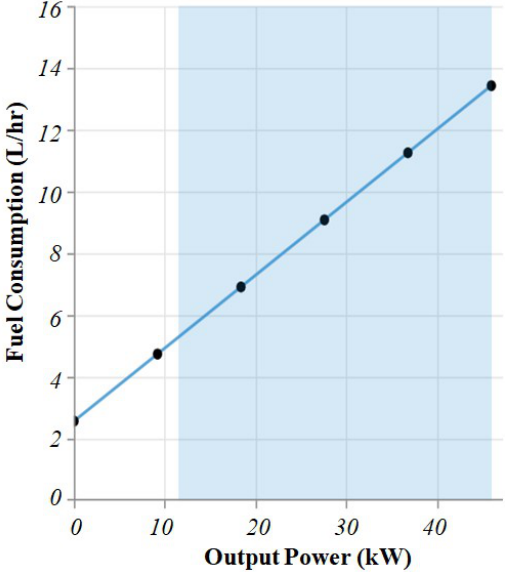
Figure 11. Fuel curve of the diesel generator.